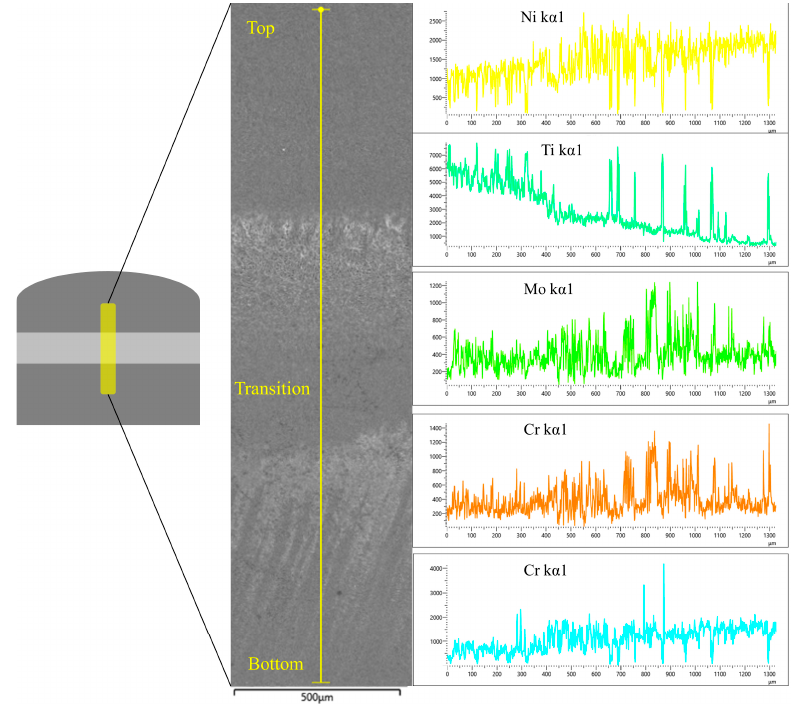
Figure 9. Single-layer sample overall element distribution.